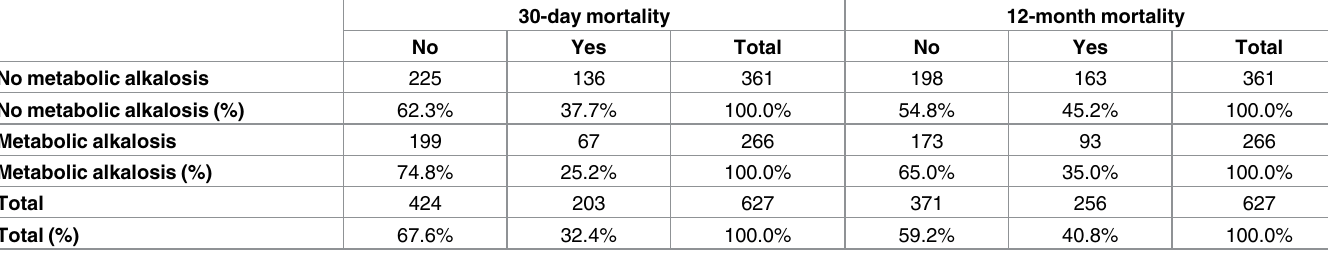
Table 2. Association between metabolic alkalosis and 30-day respectively 12-month mortality.